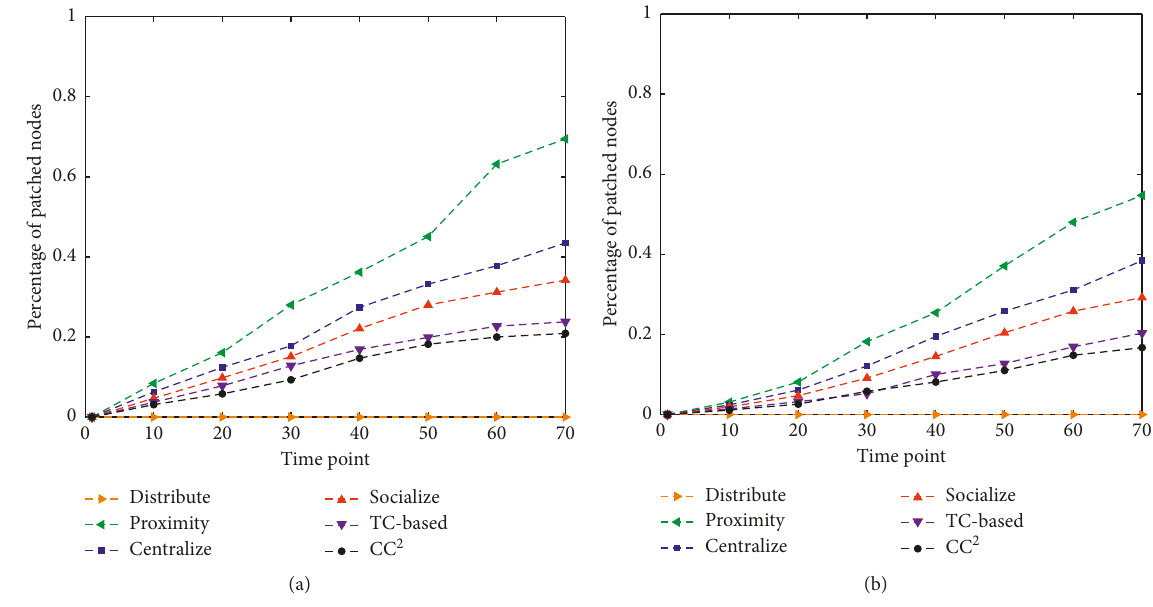
Figure 9: Performance comparison of the percentage of patched nodes on Haggle (a) and MIT Reality (b).